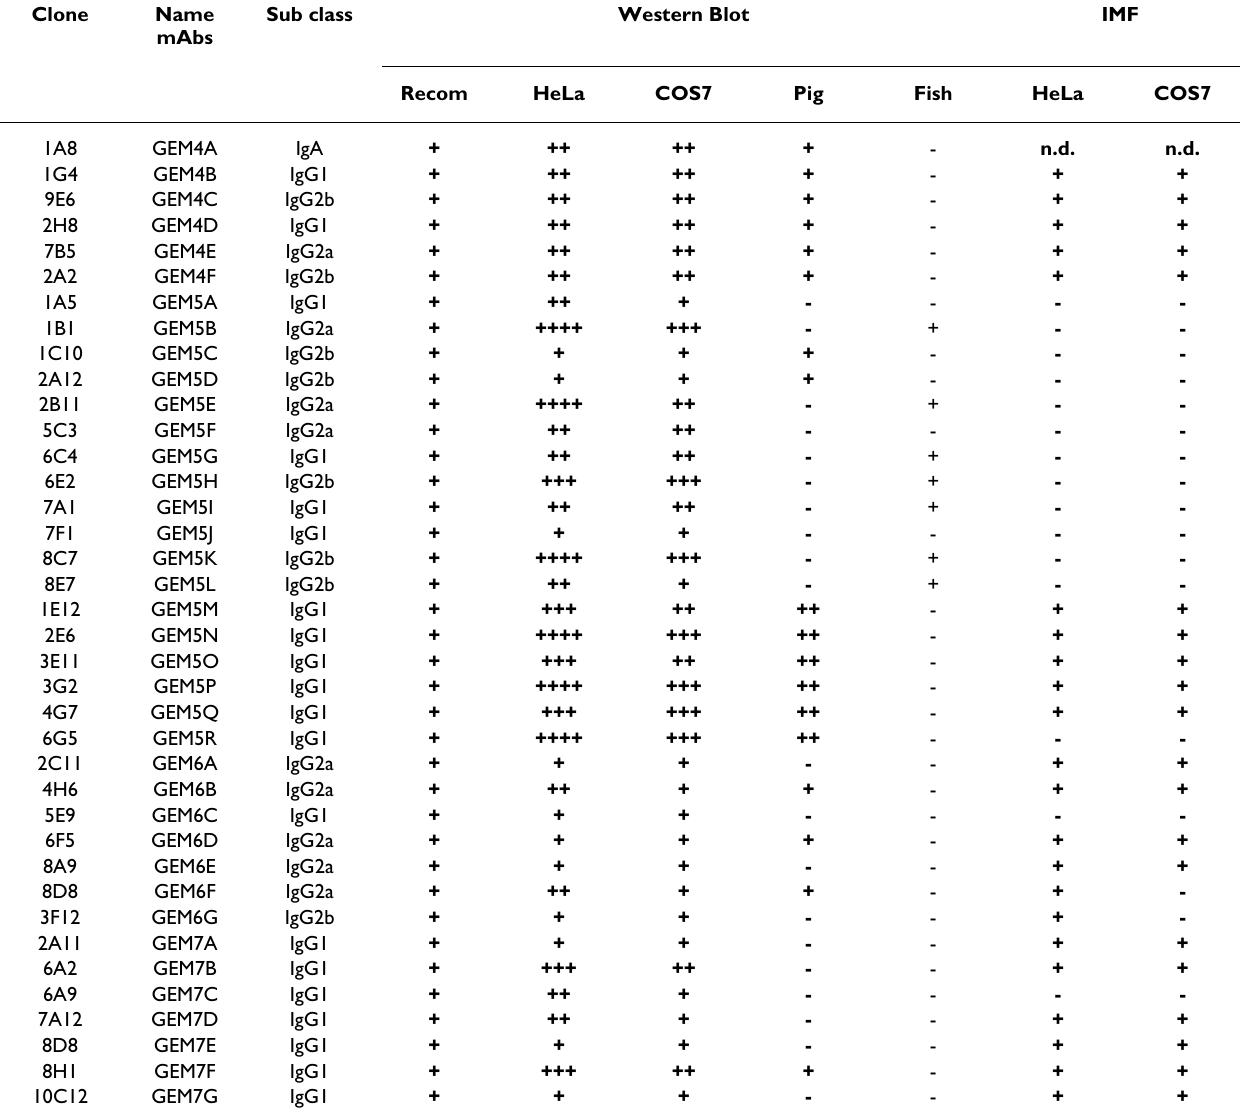
Table 1: Characterization of gemin monoclonal